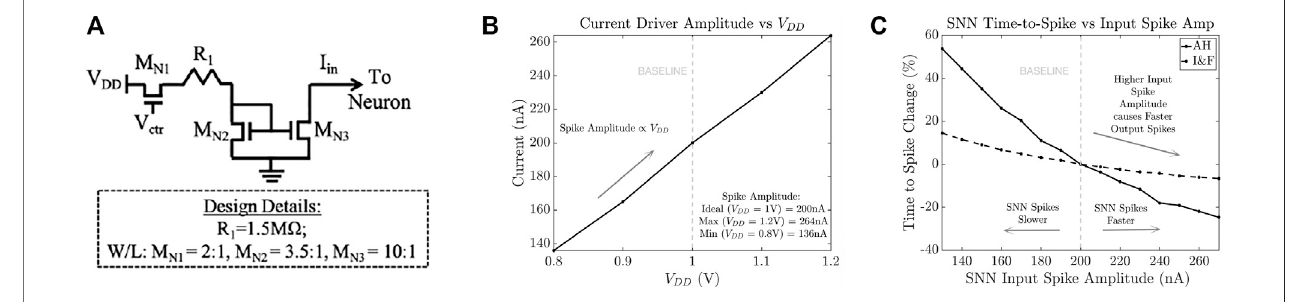
FIGURE 4 | (A) Current driver circuit of the SNN neurons with design details; (B) change in current driver output spike ( I in ) amplitude with change in V DD ; and (C) effect of input spike amplitude on SNN output time-to-spike for Axon Hillock neuron and voltage ampli fi er I&F